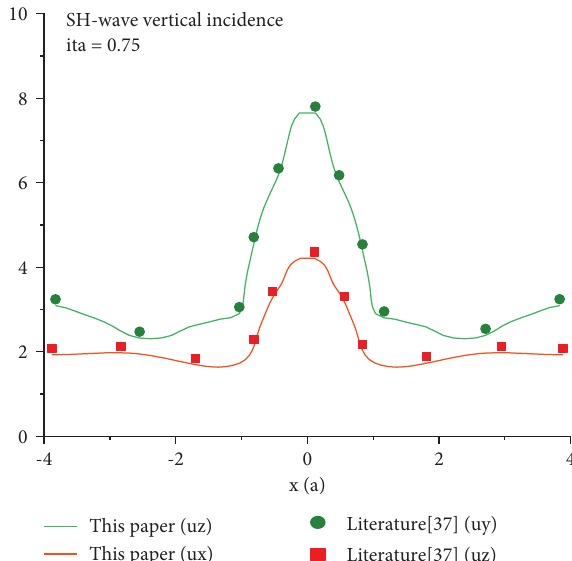
Figure 9: Surface displacement amplitude by SH-wave vertical incidence ( Y � 0 and Z � 0).